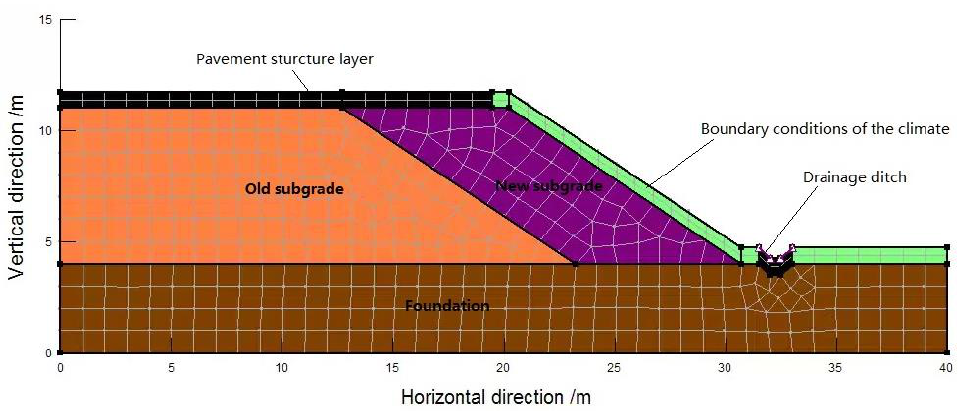
Figure 5. Numerical calculation model for the temperature and moisture of old and new subgrades.